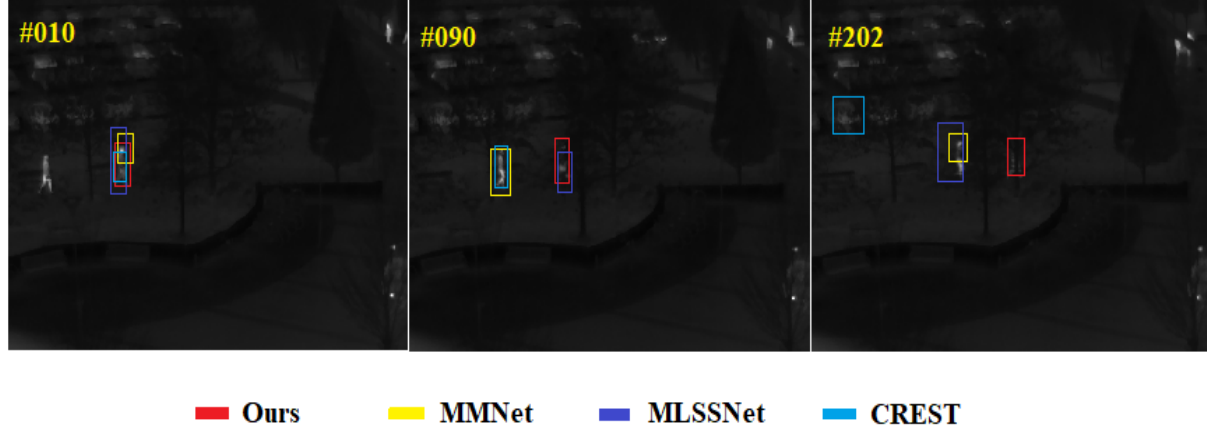
Figure 11. The visualization of tracking results in the sequence trees.